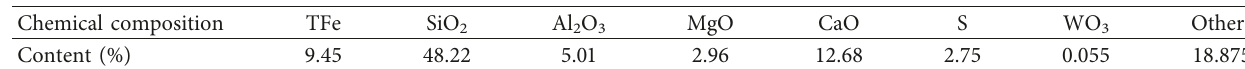
Table 2: Full-tail grading